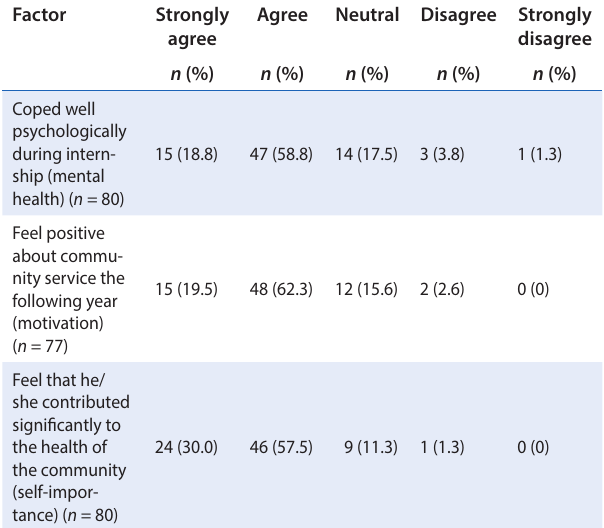
Table 2: Perceived psychological impact of internship as reported by the medical interns Factor Strongly agree